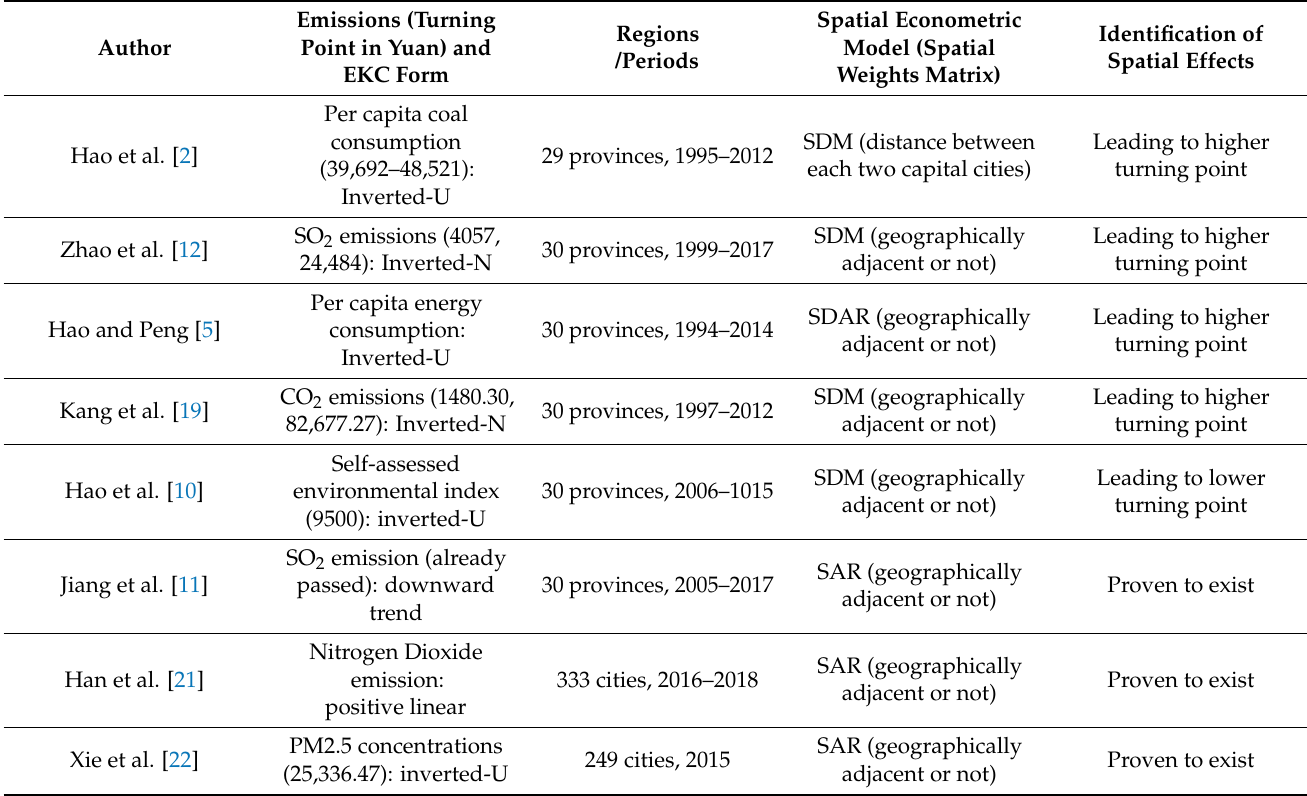
Table 1. Review of the EKC literature that takes into account the effects of spatial